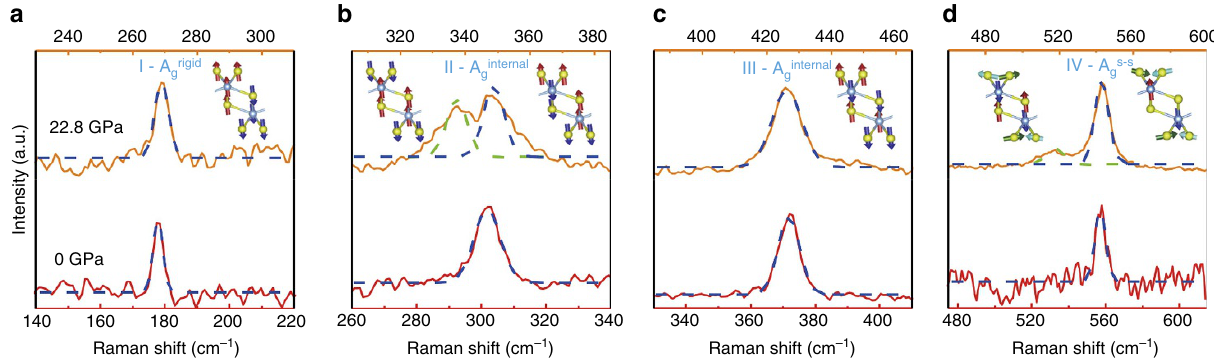
Figure 5 | A comparison between the shape of each Raman peak at 0 and 22.8GPa. ( a ) I-A g rigid mode, ( b ) II-A g internal mode, ( c ) III-A g internal mode ( d ) and IV-A g s–s